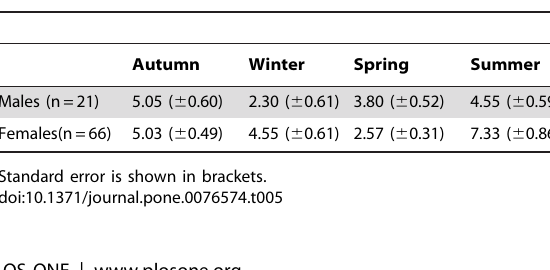
Table 5. The mean number of sightings of individual adult male and adult female bottlenose dolphins for each Australasian season (March 2007 and November 2009).